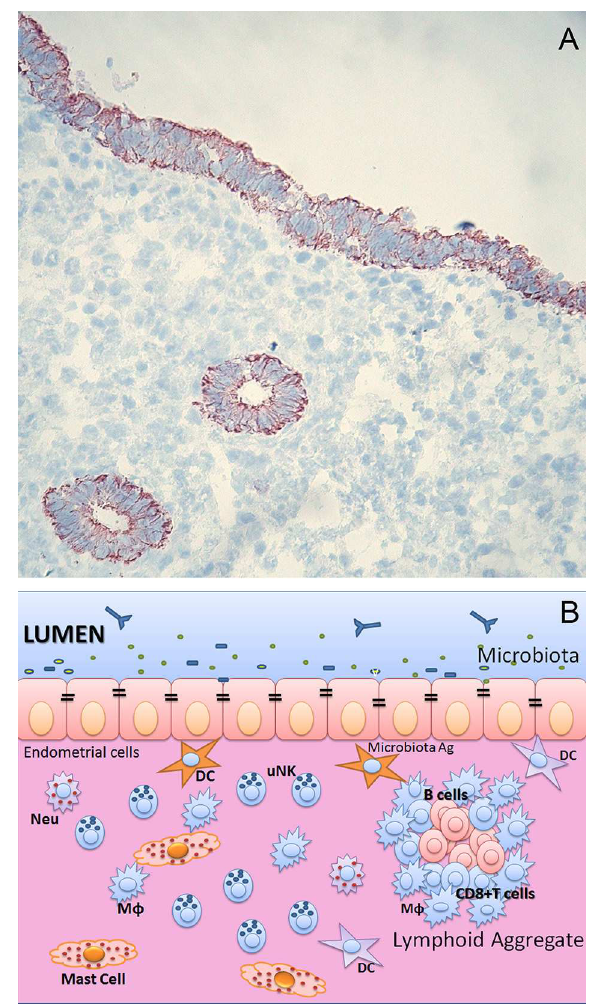
FIGURE 1 | (A) Endometrium of human uterus. Immunohistochemical analysis of human endometrium on frozen section stained with CK7 monoclonal antibody (Dako) of uterus in proliferative phase. Bound antibody was revealed using the LSAB + HRP kit and 3,3 ′ -diaminobenzidine tetrahydrochloride (DAB) as chromogen. The sections were counterstained with hematoxylin. Monostratified columnar epithelium and the basal layer, which remains intact during menstruation, is occupied by the base of the uterine glands. Original magnifications 200 × . (B) Immunological components of uterine mucosa. The endometrium is populated by a range of immune cells, such as mast cells, Macrophages (M 8 ), Neutrophils (Neu), Dendritic cells (DC), T and B cells. The presence of lymphoid aggregates in the endometrial tissue suggests that this is an active site for cell-mediated immunity. Lymphoid aggregates found beneath the endometrium are composed of B cells in the inner core, surrounded by CD8 + CD4 − T cells and an outer layer of macrophages. Scattered CD56 + natural killer (NK) cells and CD4 + T cells can also be found in between lymphoid